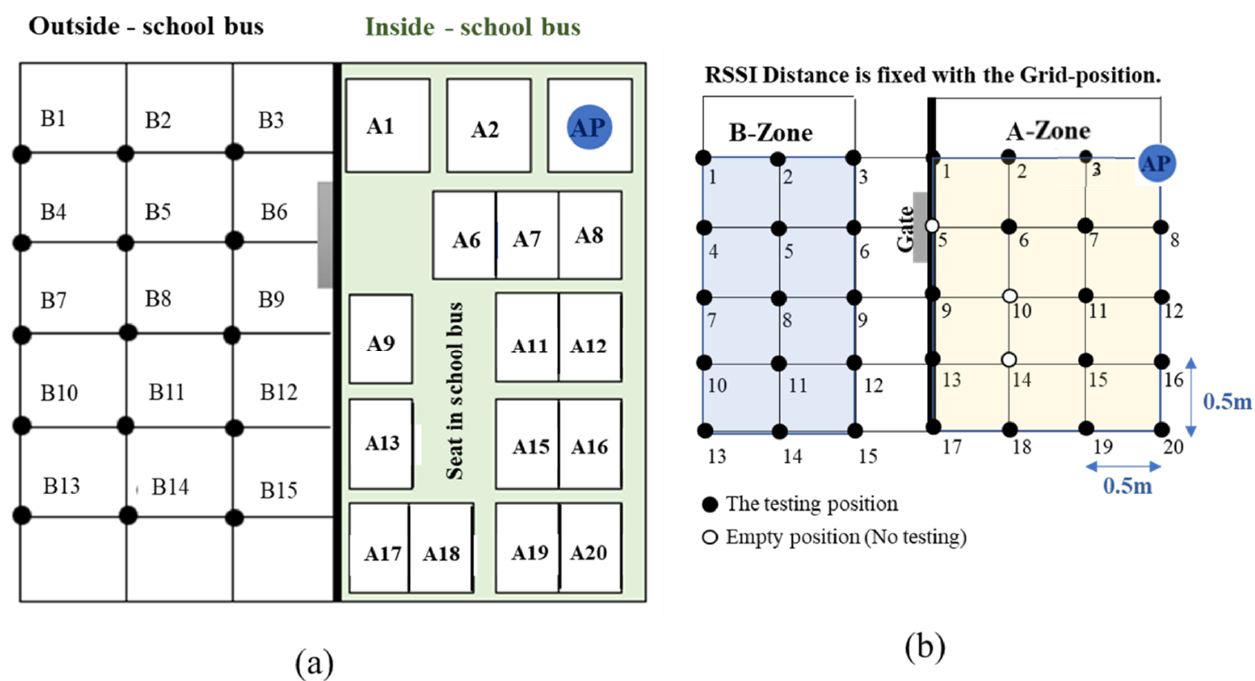
Figure 1. An application scenario about ( a ) the location set with a set of devices in it ( b ) Grid defining the distance calculator of the possible positions.